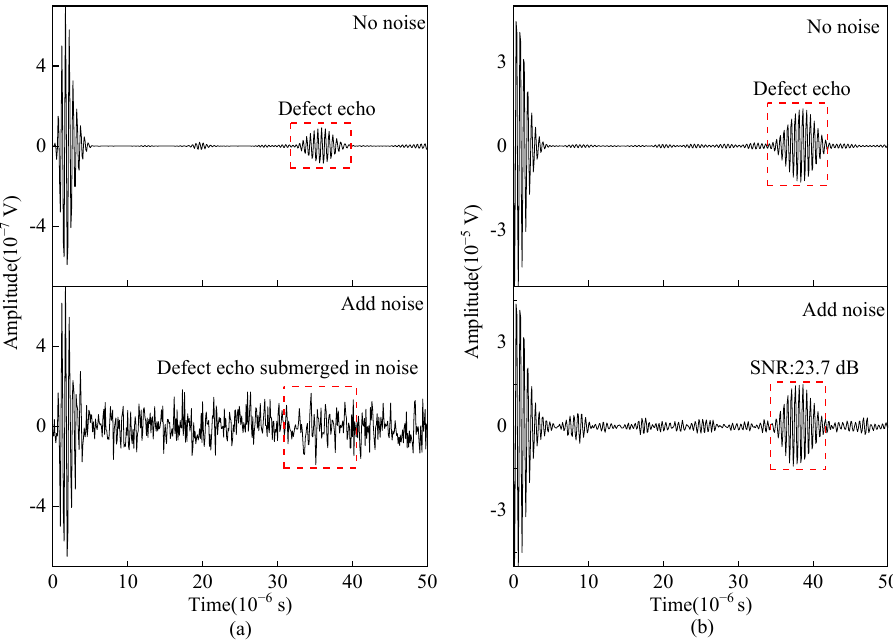
Figure 18. Simulated ultrasonic signal from angled SV wave EMAT with ( a ) the tone-burst excitation method ( b ) the Barker code pulse compression technique.